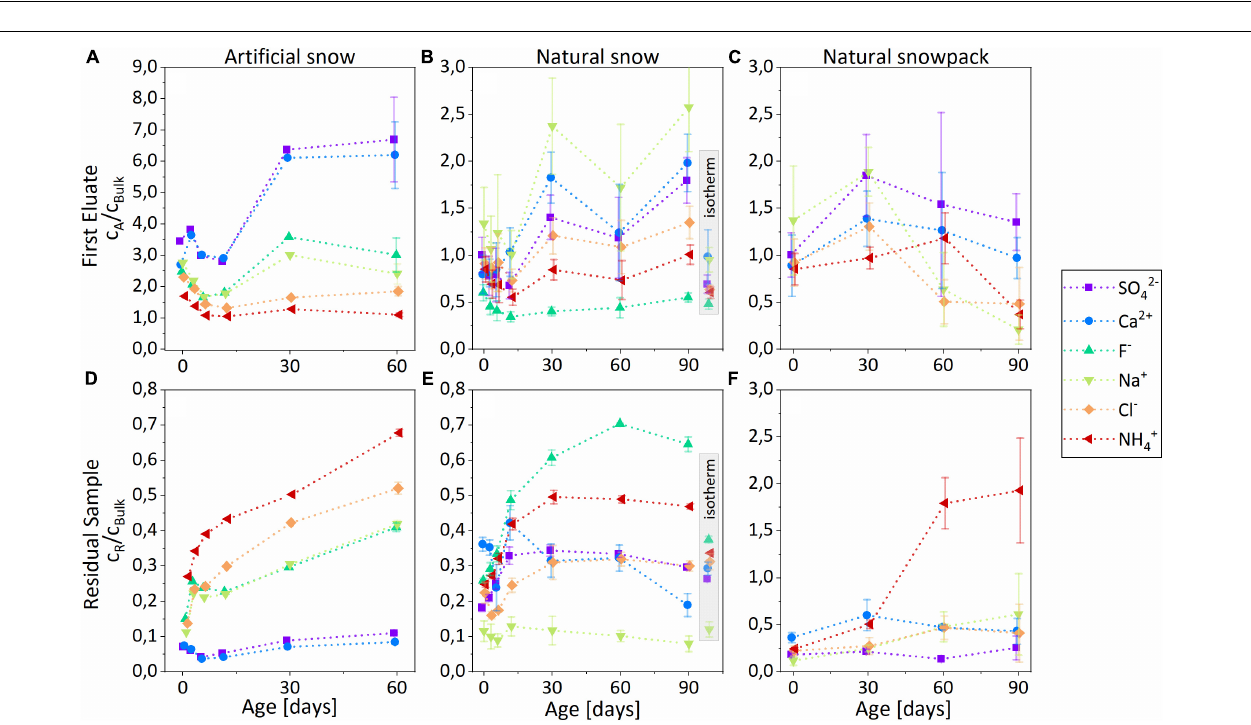
FIGURE 5 | Elution profiles of NH 4 + (red) and Ca 2 + (blue) of the natural snow sample after 0 days (A) and 30 days (B) temperature gradient metamorphism. Concentrations are normalized to the respective bulk concentration. c A denotes the first eluate and c R the molten residual snow sample. Error bars represent 1 σ uncertainties of three snow samples.